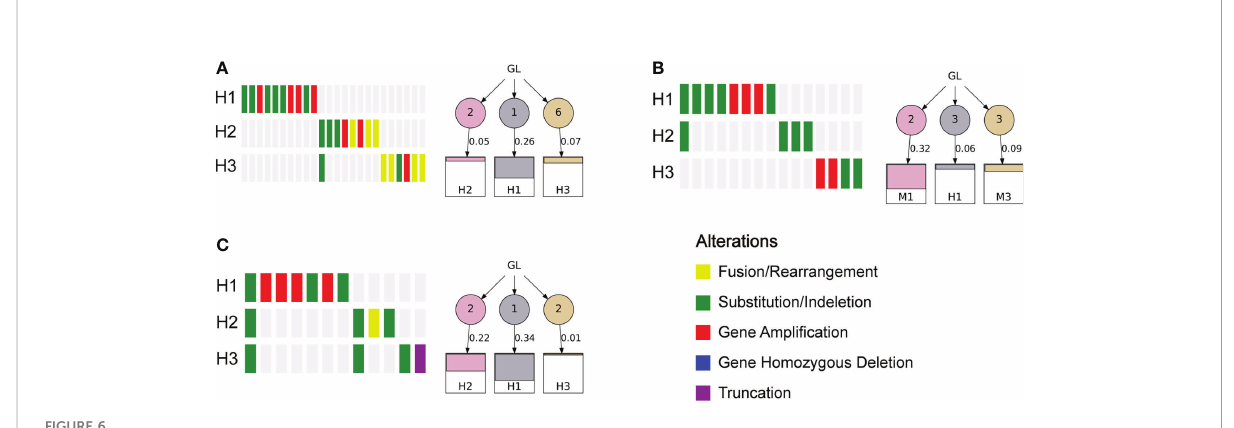
FIGURE 6 Gene alterations and polygenetic tree of the triple-primary LUAD